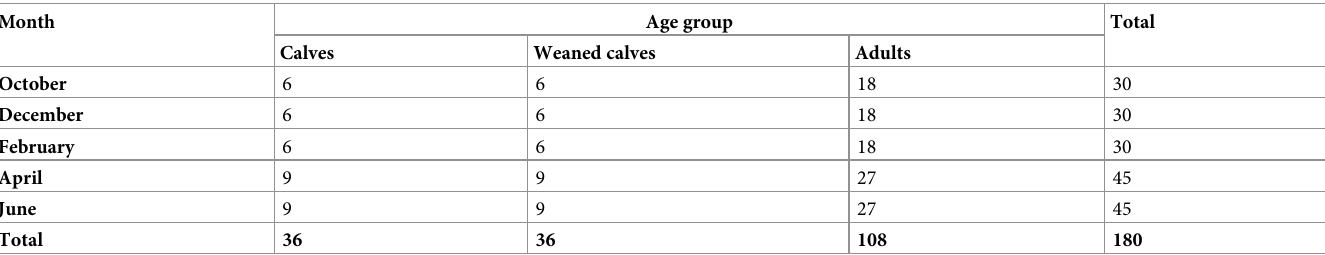
Table 1. Fecal samples collected per visit according to the cattle age